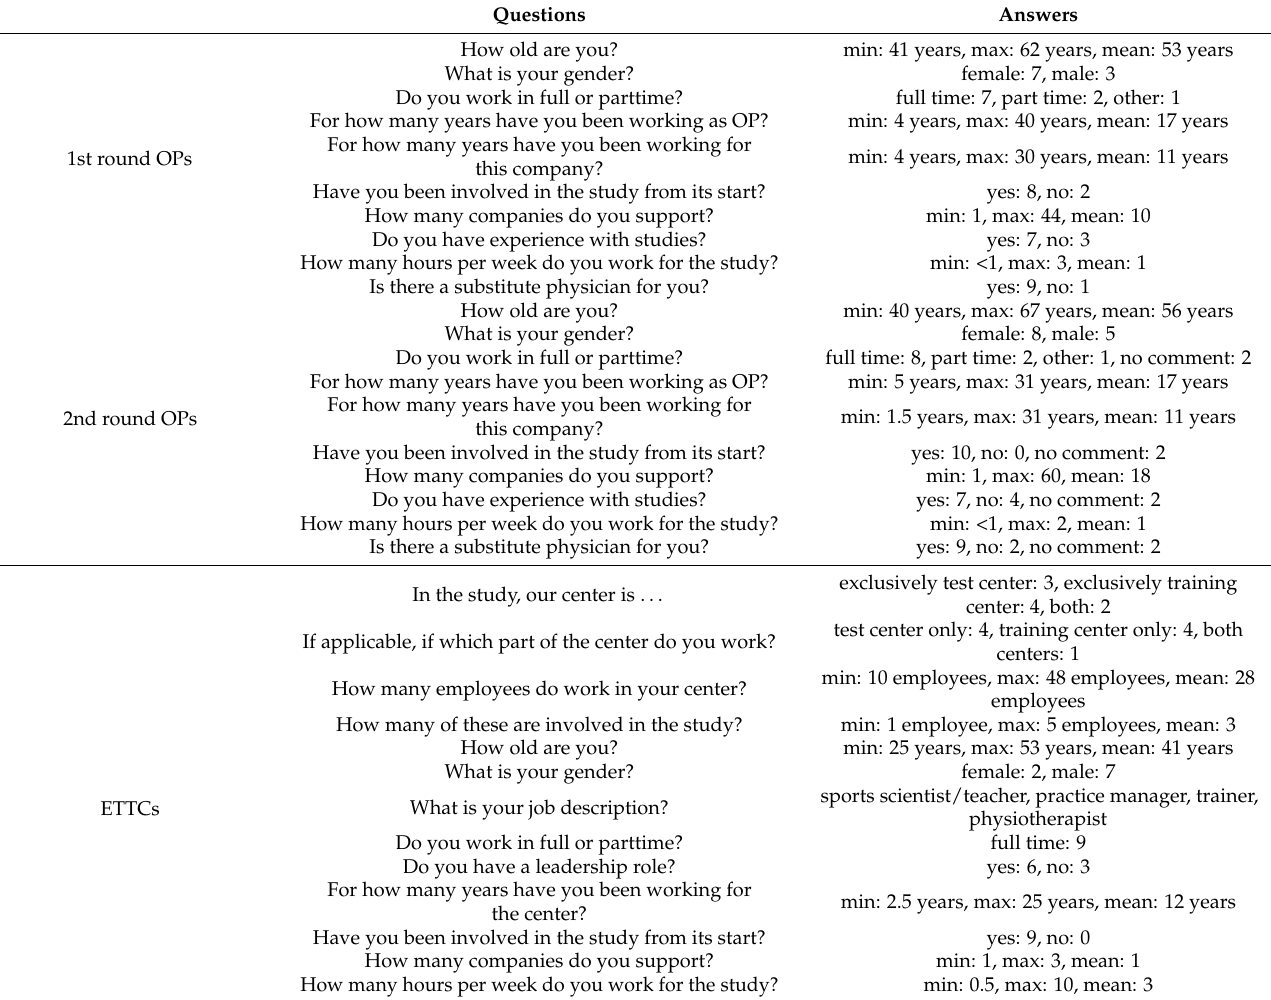
Table 1. Sociodemographic details of study